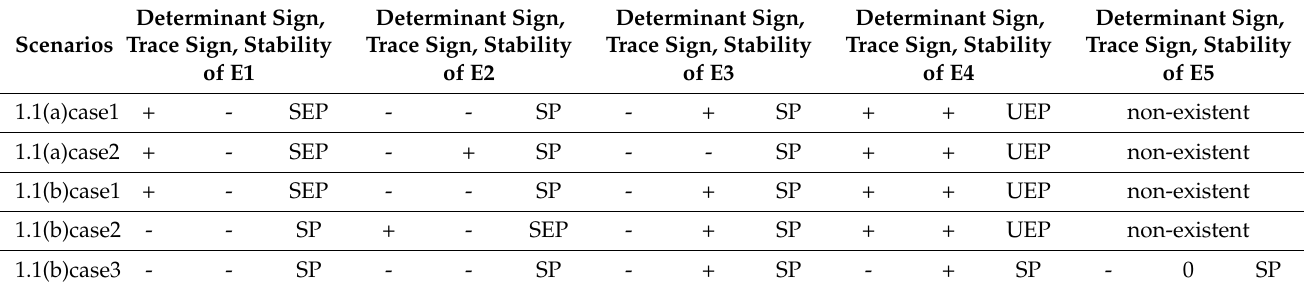
Table 3. Local equilibrium point stability analysis of scenario 1.